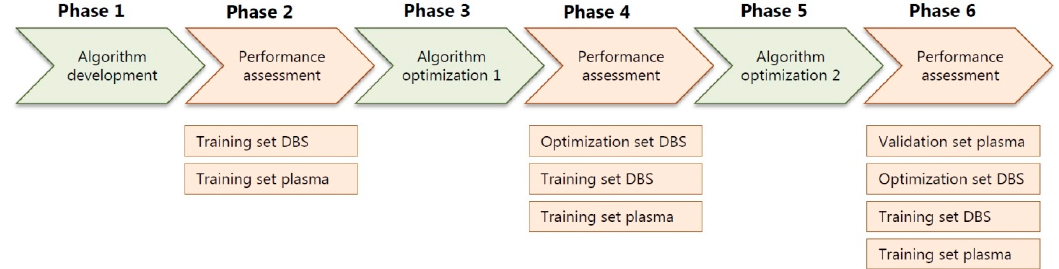
Figure 2. Flowchart of the six phases of the development and optimization of the diagnostic algorithm, with in-between assessments of the performance of the algorithm in the training sets, DBS optimization set and plasma validation set. DBS: dried blood spots.